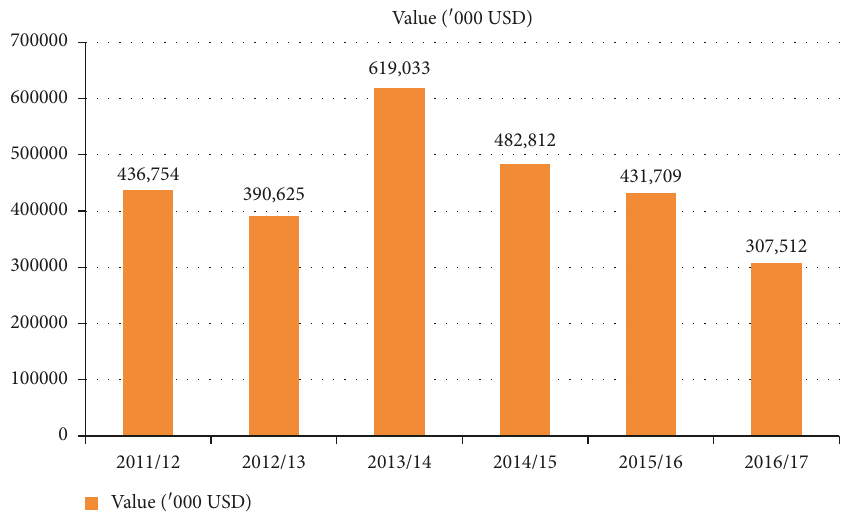
Figure 1: Value ($USD) of exported Ethiopian sesame (2011/12-2016/17) (MoT,